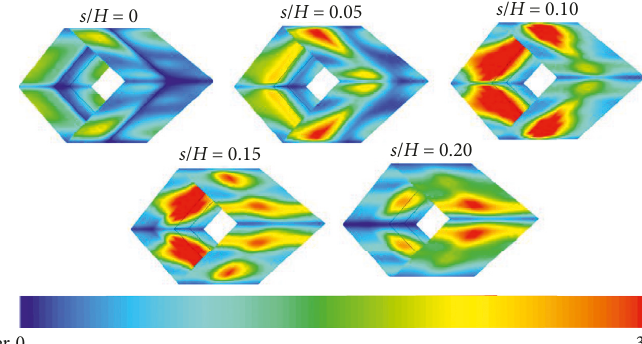
Figure 14: Nu x of the heat exchanger square duct installed with the 45